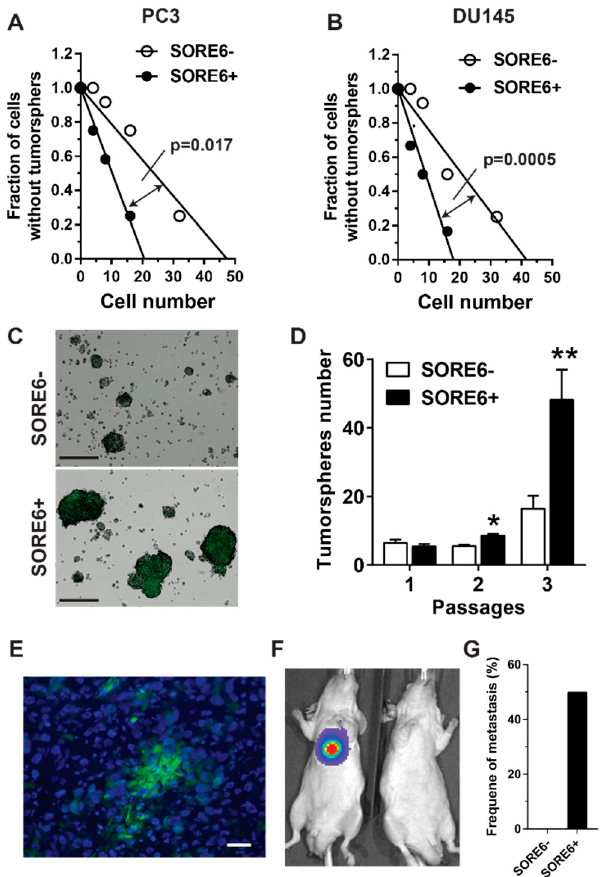
Figure 2. Increased self-renewal, tumorsphere- and metastasis-forming frequency in SORE6 + cells. SORE6 + and SORE6 − cells were sorted from ( A , C – F ) PC3 and ( B ) DU145 cells and plated on ( A , B ) 96-well plates for limiting dilution assays, ( C , D ) 6-well plates for self-renewal and tumorsphere-forming assays, or ( E – G ) injected into mice via the left ventricle for metastasis-forming assays. ( A , B ) The plots of the PC3 ( A ) and DU145 tumorsphere formation ( B ). ( C , D ) The representative images and quantitative data of the PC3 cell tumorsphere formation on 6-well plates at various passages, scale bar: 200 μ m *, ** p < 0.05 and 0.01 versus SORE6 − , respectively, n = 3. ( E ) A representative fluorescence image of tumor sections prepared from tumors derived from SORE6 + PC3 cells, scale bar: 25 μ m. ( F , G ) The formation of lung metastases in nude mice injected with SORE6 + PC3 cells. ( F ) Representative bioluminescence images and ( G ) quantitative data, of lung metastases are shown.